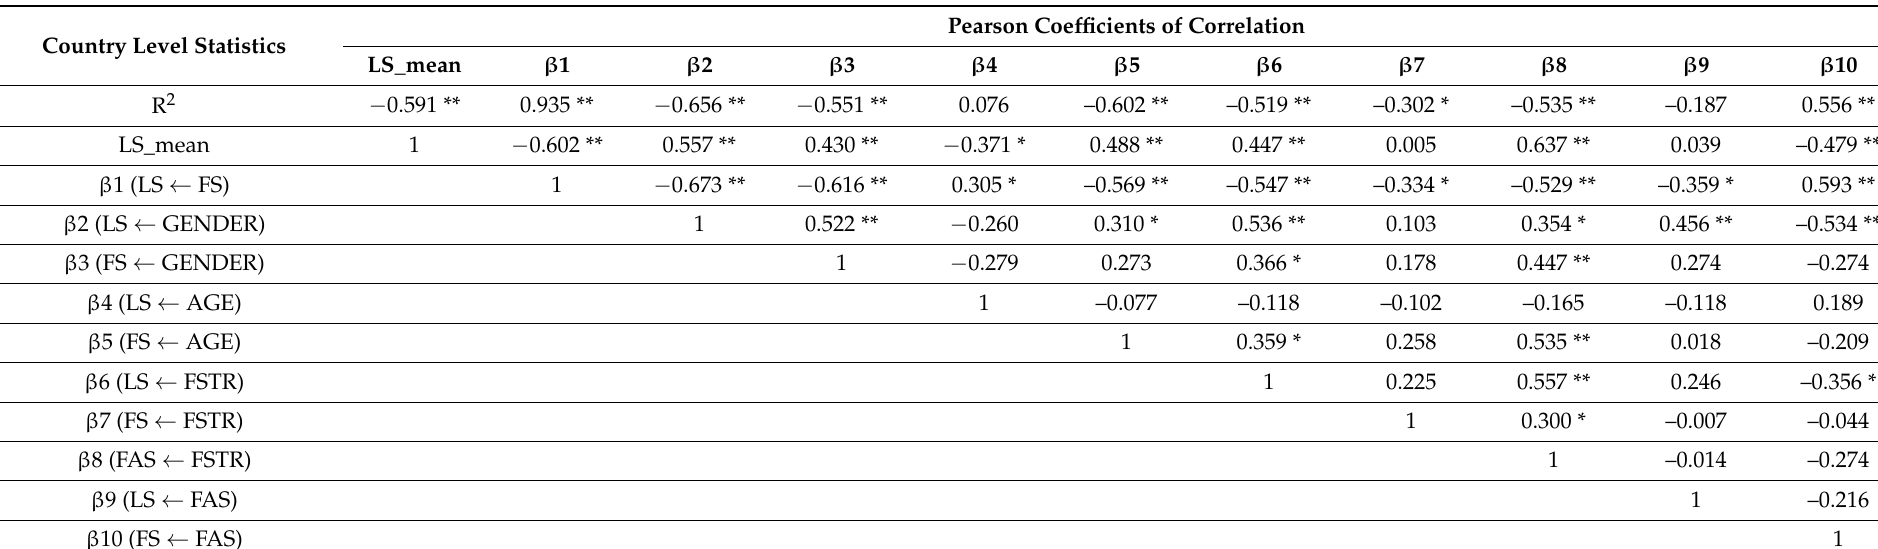
Table 8. Correlations between R 2 , mean of life satisfaction score (LS_mean) and path regression weights estimated from the country-level